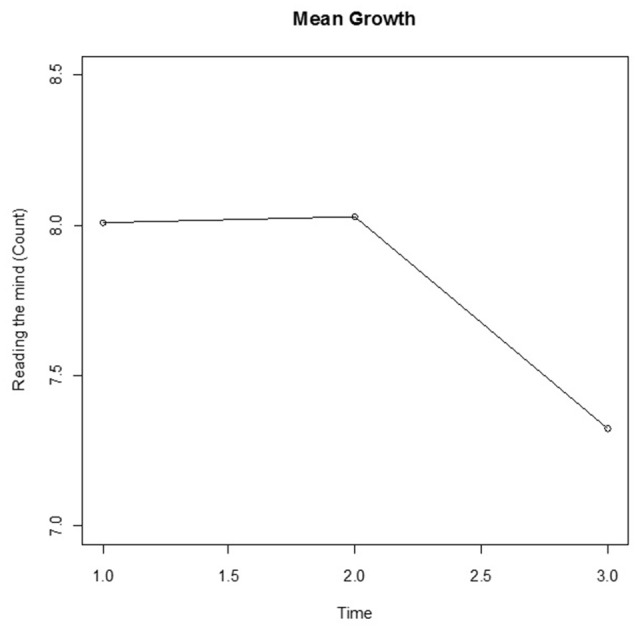
Mean change of total score (Count) for the RMET-R dataset.